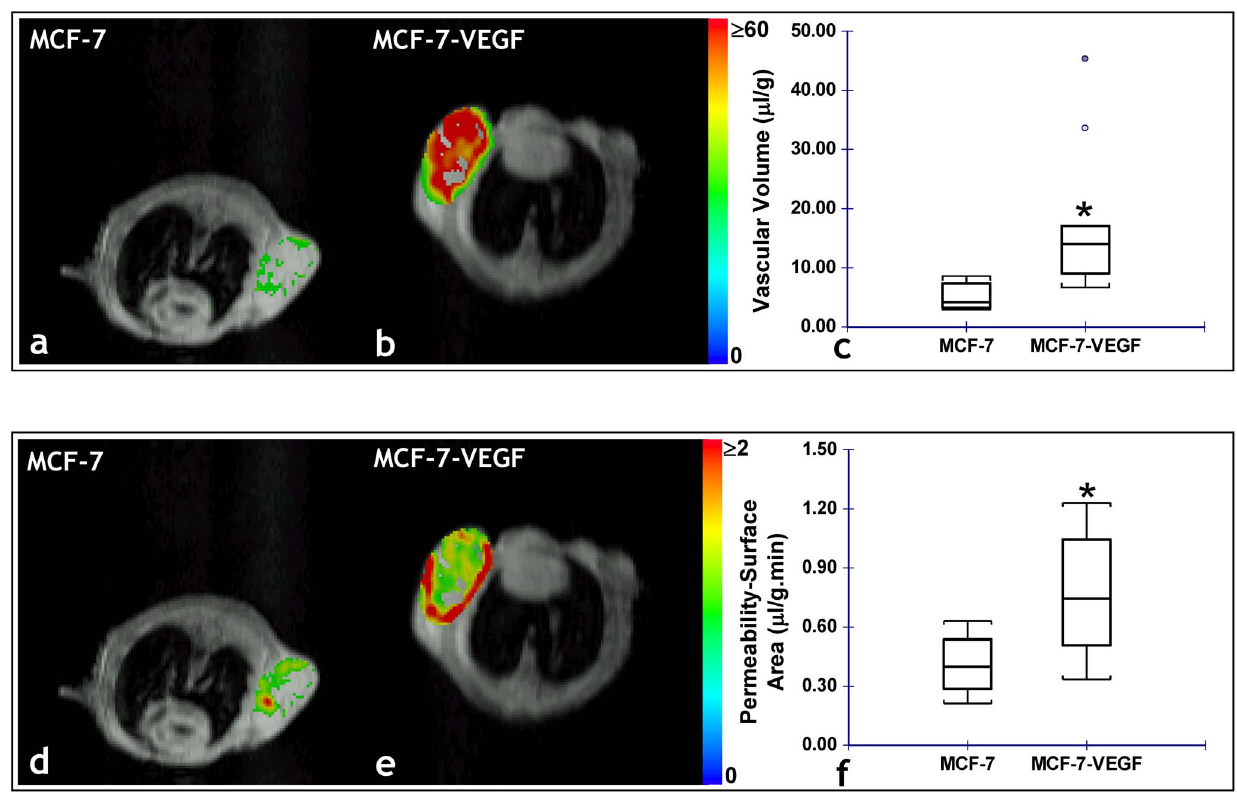
Figure 3. Invivo MRI reveals VEGF overexpression alters the angiogenic phenotype of MCF-7 tumors. Representative functional MRI maps of the vascular volume from: (a) MCF-7 and (b) MCF-7 VEGF overexpressing tumor bearing animals. (c) Box-and-whisker plot comparing the vascular volume between MCF-7 (n=10) and MCF-7-VEGF (n=12) xenografts. The length of each box is the interquartile range (IQR), while the line through the middle of each box is the median value. The T-shaped lines extending from each end of the box represent the upper adjacent value (i.e. the largest observation # 75th percentile + 1.5 6 IQR) and the lower adjacent value (i.e. the smallest observation # 25th percentile–1.5 6 IQR), and gray dots denote values outside this range (*p=0.000059 with the two-tailed Mann-Whitney U Test). Representative functional MRI maps of the permeability-surface area product from: (d) MCF-7 and (e) MCF-7 VEGF overexpressing tumor-bearing animals. (f) Box-and-whisker plot comparing the permeability-surface area product between MCF-7 (n=10) and MCF-7-VEGF (n=12) xenografts (*p=0.0026 with the two-tailed Mann-Whitney U Test).